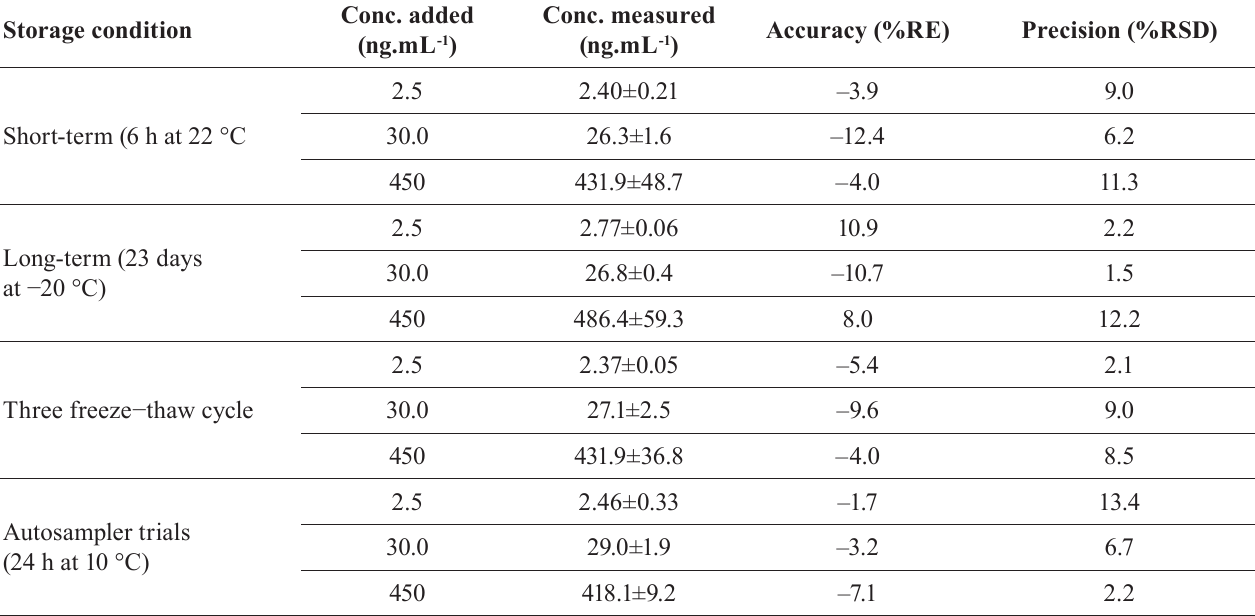
TABLE II - Stability of lobetyolin QC samples in rat plasma (n=5)